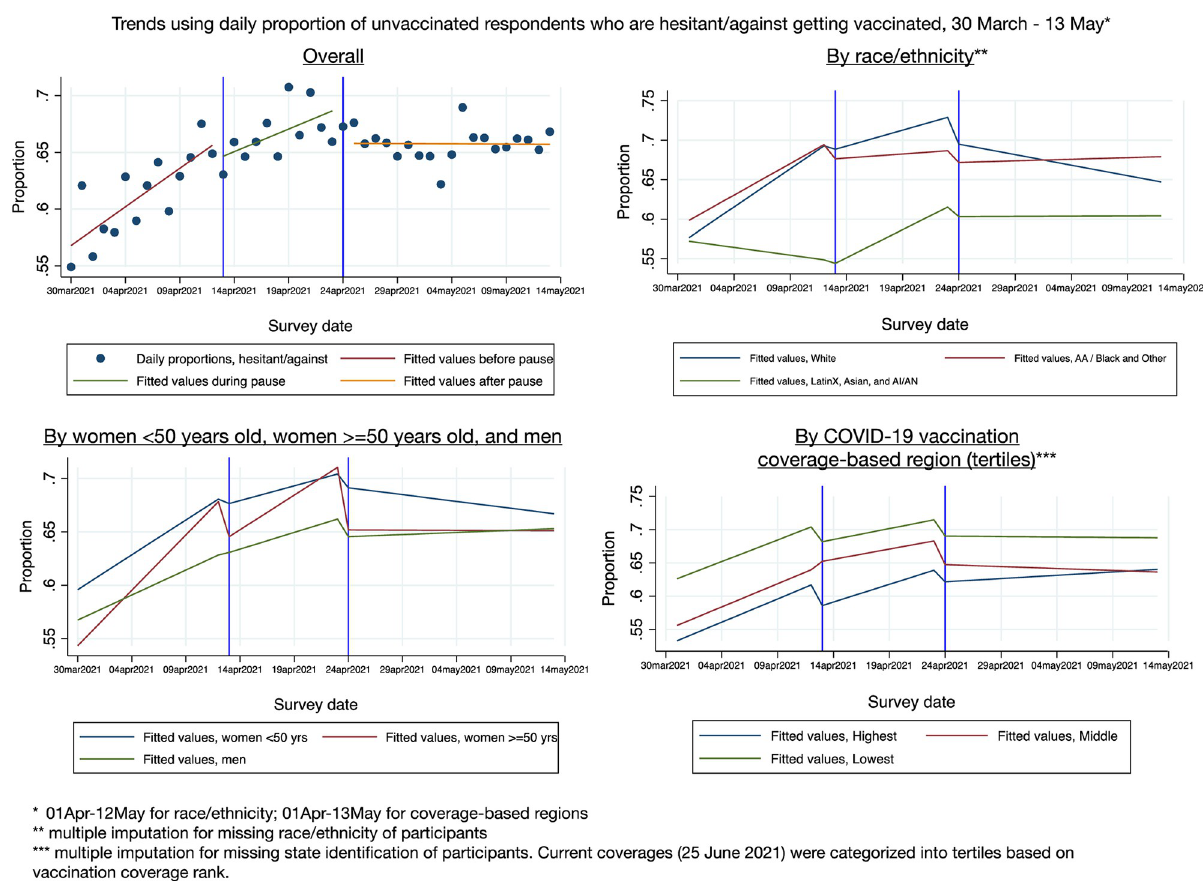
Fig 1. Trends in proportion of unvaccinated individuals (n = 56,193) with hesitant/against COVID-19 vaccination attitudes over three time periods (pre-, during-, and post-J&J pause), overall and stratified by race/ethnicity, women < 50 years of age versus women > = 50 years of age and men, and COVID-19 coverage-based